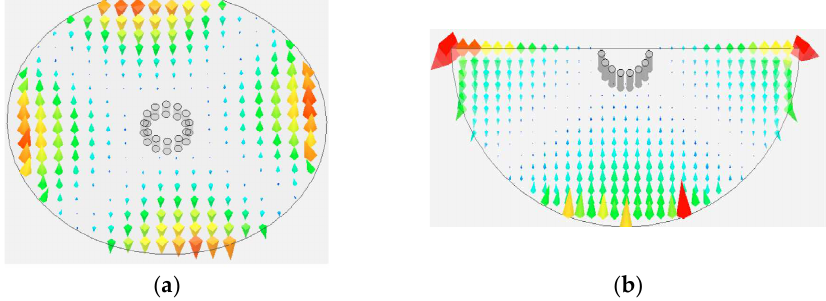
Figure 4. Electric field distributions of the TM210 mode of the two patch resonators. ( a ) Circular patch resonator; ( b ) semicircular patch resonator.